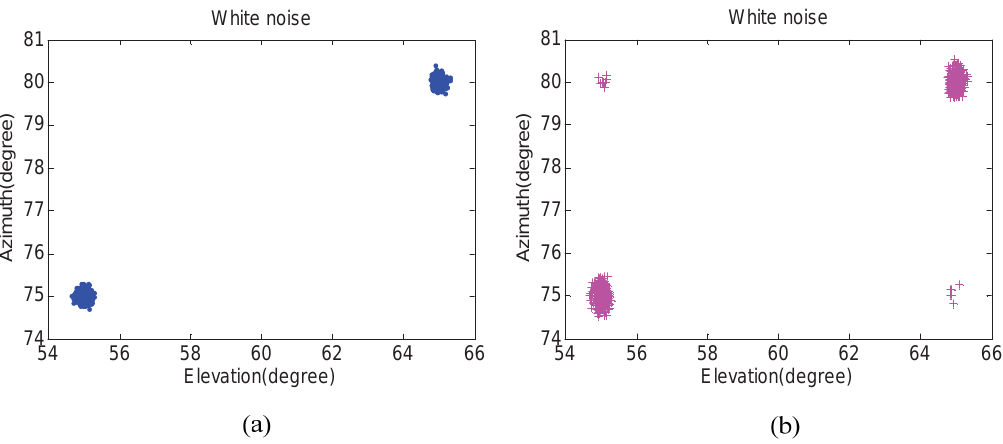
Figure 3. The angle estimation scattergram in a white noise situation. ( a ) The proposed algorithm; and ( b ) the Kikuchi algorithm.